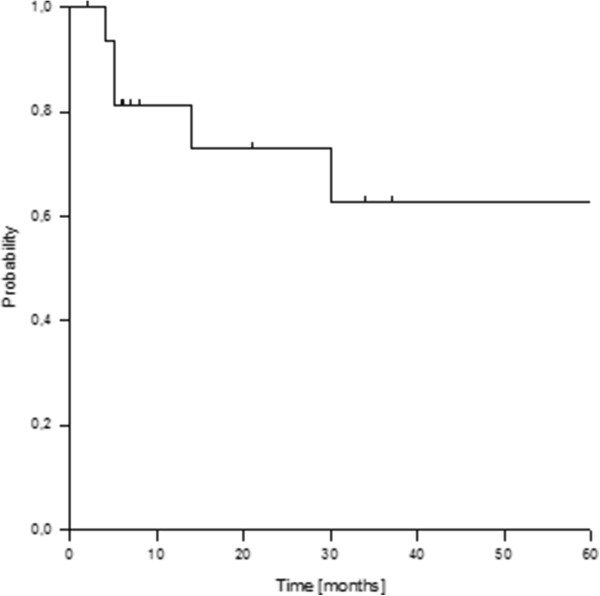
Overall survival.